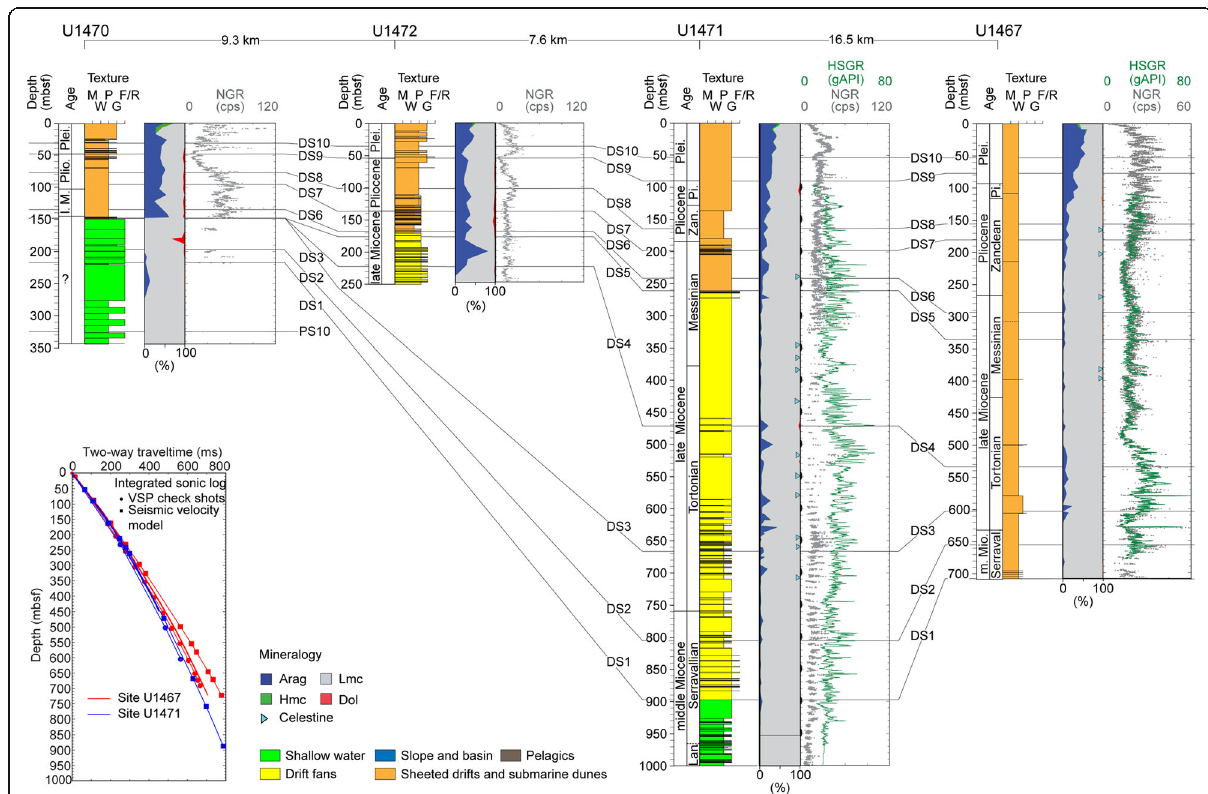
Fig. 5 Sequence stratigraphic correlation of IODP sites along the southern transect of wells in the Maldives (see Fig. 1 for locations). HSGR: downhole gamma ray log; NGR: gamma ray counts on whole cores. See text for details. Inset to the left shows the time-depth curves for Sites U1467 and U1471 with VSP check shot stations. M mudstone, W wackestone, P packstone, G grainstone, F/R floatstone/rudstone. Carbonate mineralogy: blue : aragonite, green : high Mg calcite, gray : low Mg calcite, red :